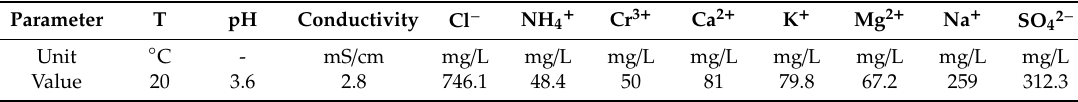
Table 3. Characterization of synthetic tannery e ffl